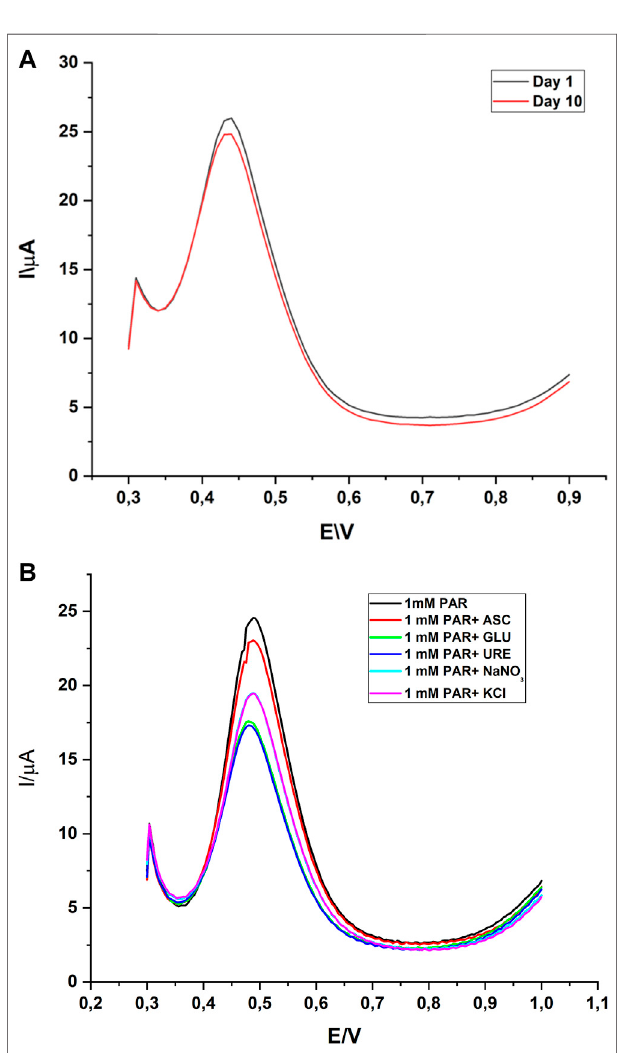
FIGURE 8 | (A) Stability studies of GCE/gCN-AgPVP for 1 Mm PAR. (B) Interference study of some co-existing compounds during the electrochemical determination of 1 mM PAR using